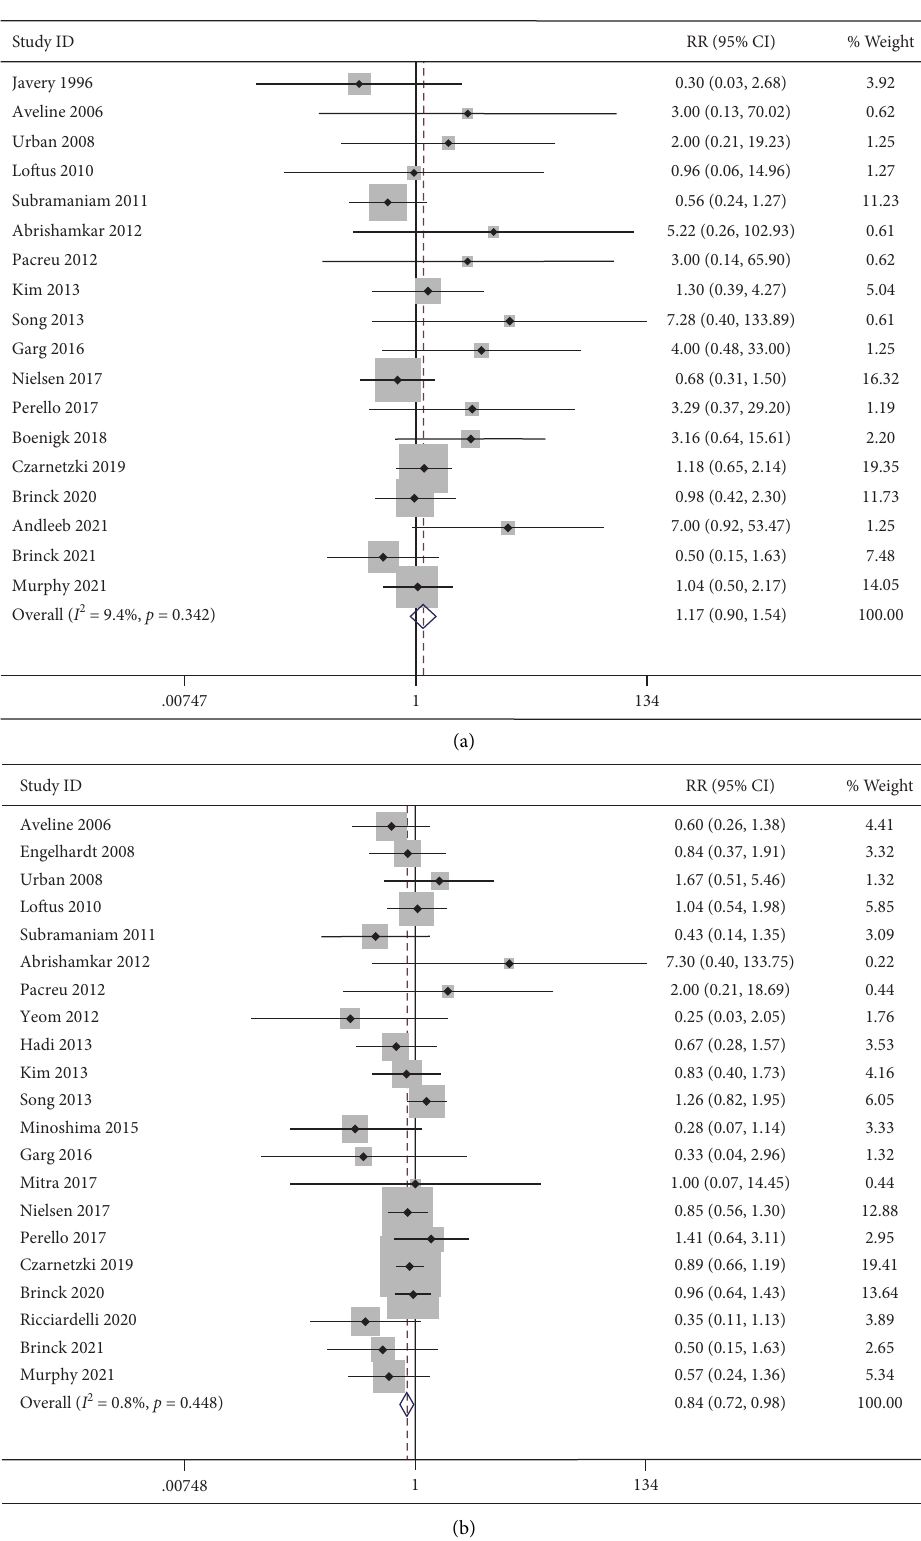
Figure 7: Forest plot of the incidence of adverse events for the ketamine group and control group. (a) CNS adverse events; (b)